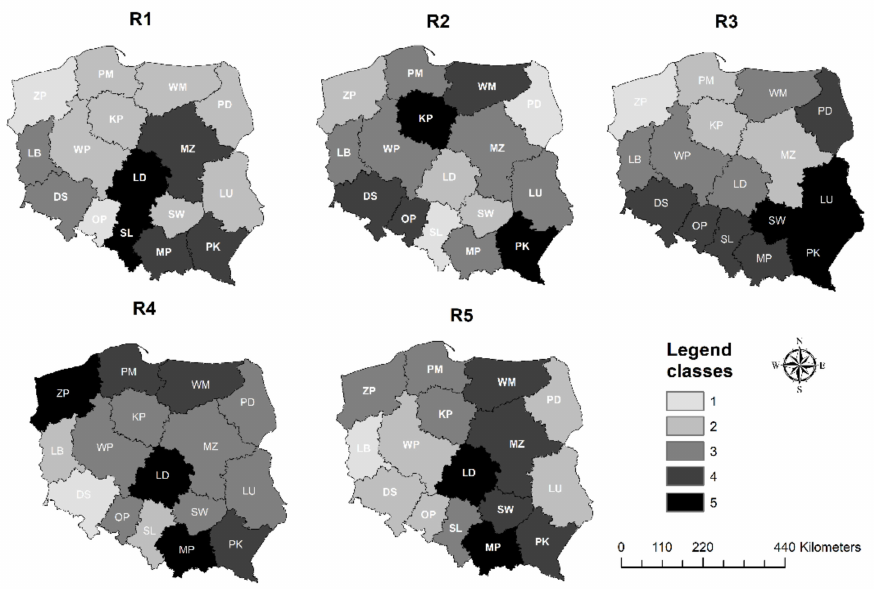
Figure 8. Road transport development evaluation. Source: the authors.